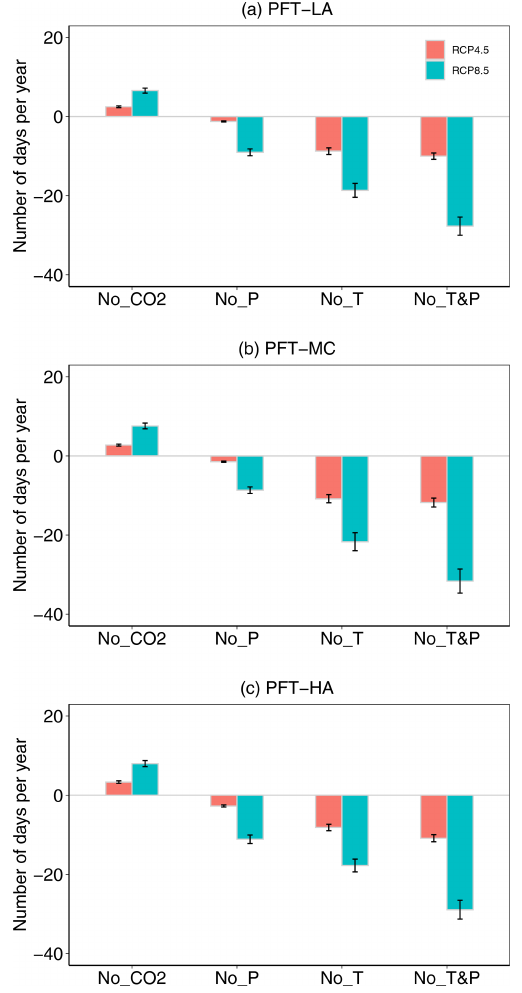
Figure 5. Differences in number of days per year of live fuel moisture content below 79% from 2080 to 2099 for three PFTs (see Fig. 1 for an explanation of the PFTs) under climate scenario RCP4.5 and 8.5 between considering all climatic variable changes and removing the CO 2 , precipitation, temperature, and precipitation and temperature